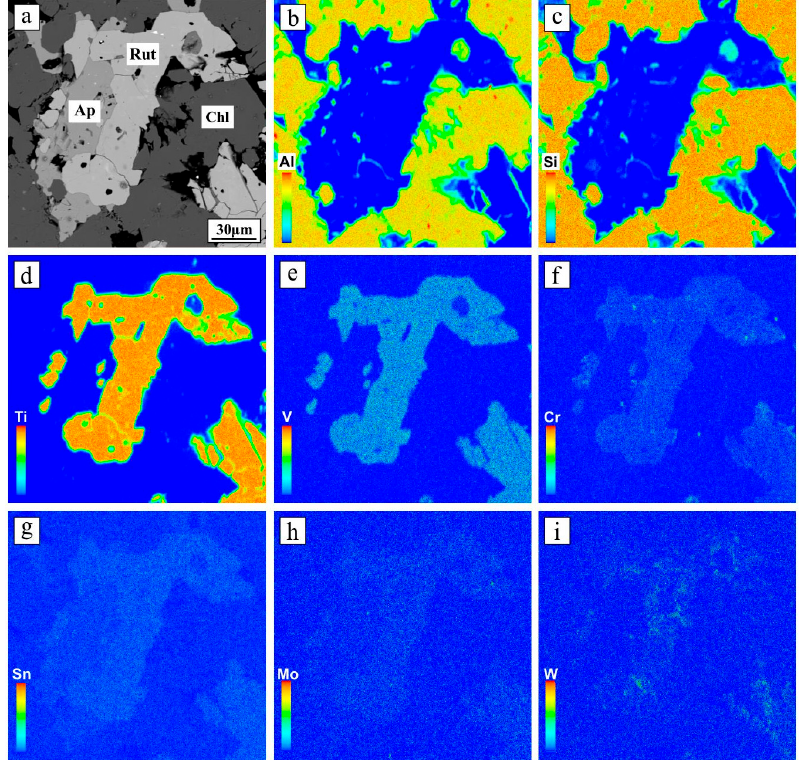
Figure 5. BSE image ( a ) of Tuwu rutile and EPMA element mapping images ( b – i ) for Al, Si, Ti, V, Cr, Sn, Mo, and W. Warmer colors correspond to higher concentrations. Abbreviations: Ap = apatite; Chl = chlorite; Rut = rutile.